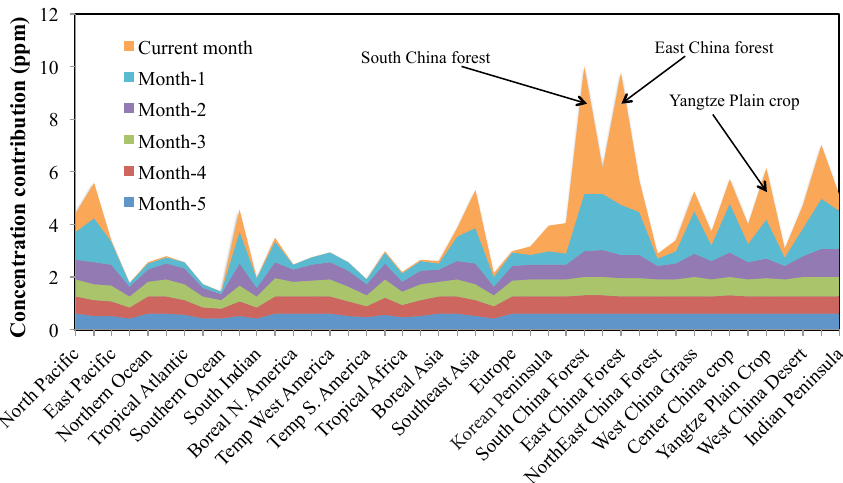
Figure 8. Contributions from emissions of different regions in July 2007 and the previous five months (1PgCmonth − 1 region − 1 ) to the CO 2 concentration in July 2007 at 2000–4000m over Taipei airport (TPE).